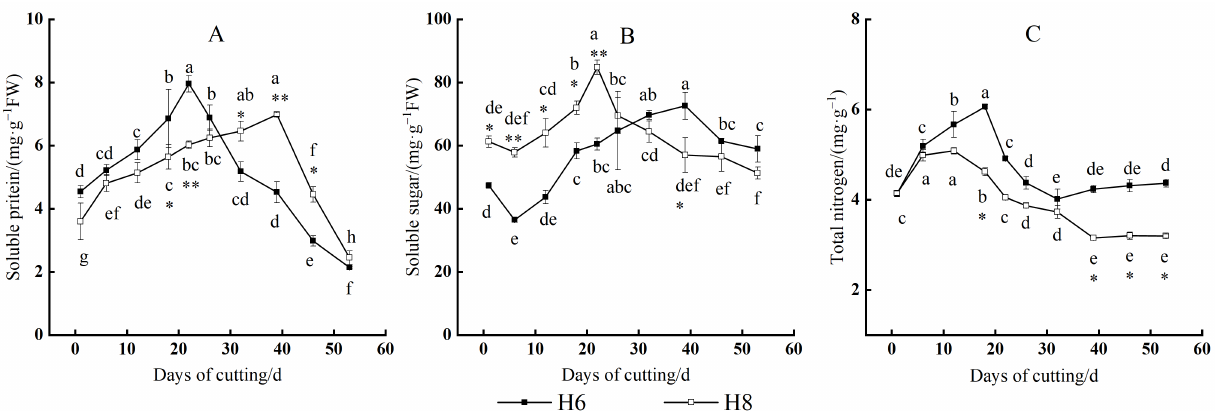
Figure 7. Dynamic changes in oxidase activity during cutting rooting of H6 and H8 in E. ulmoides. ( A ) Changes in POD activity. ( B ) Changes in PPO activity. ( C ) Changes in IAAO activity. POD—Peroxidase; PPO—Polyphenol oxidase; IAAO— Indoleacetic acid oxidase. The data are shown as the means ± SEs ( n = 3). Means with the same letter are not significantly different in the same group. * indicates significant difference between the H6 group and the H8 group at the same time. * and ** indicate means at the level of 0.05 and 0.01,